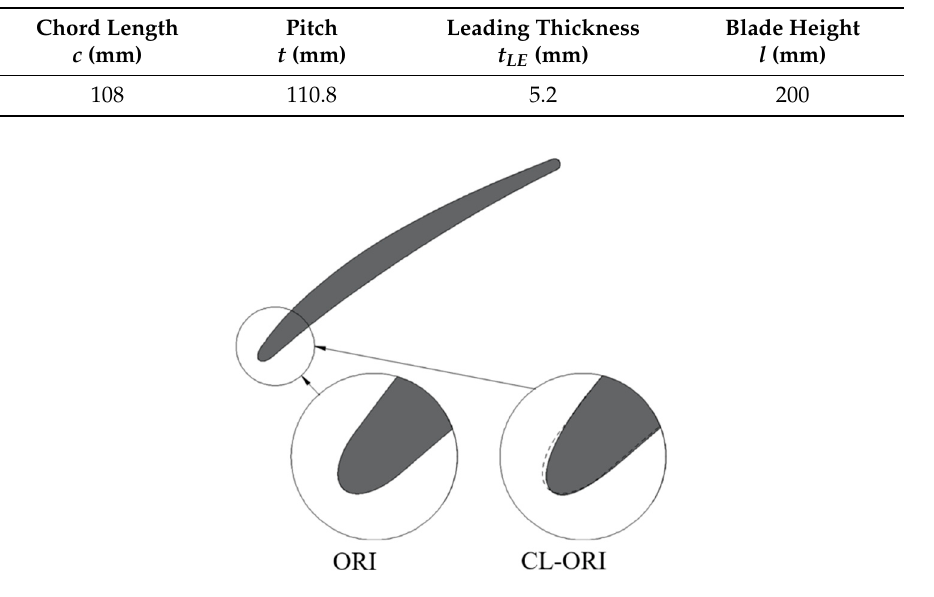
Table 1. The physical parameters of the cascades